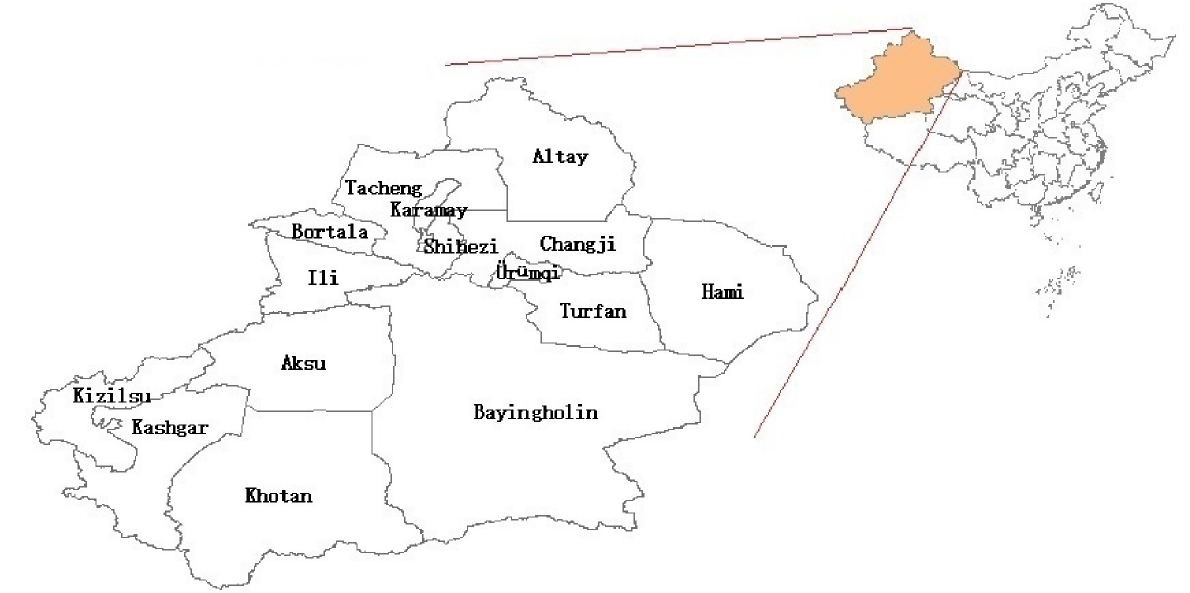
Fig 1. Map of Xinjiang province, China. It is generated by software ArcGIS 10.2 from http://eol.jsc.nasa.gov/SearchPhotos/.